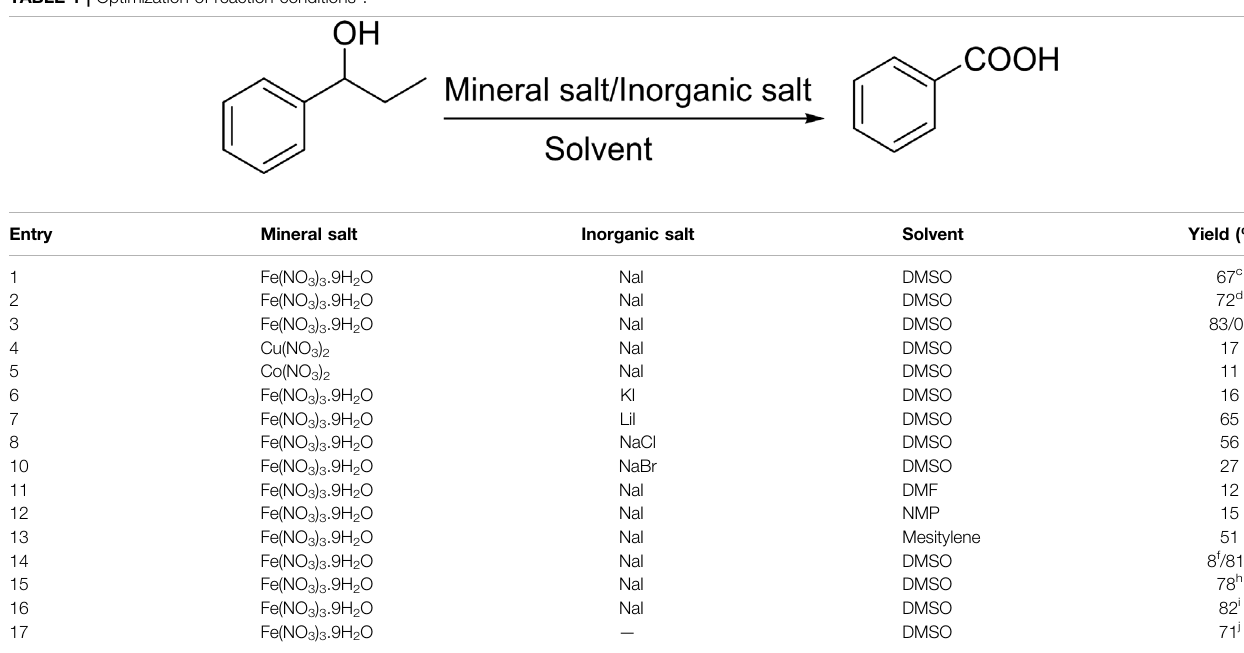
TABLE 1 | Optimization of reaction conditions a